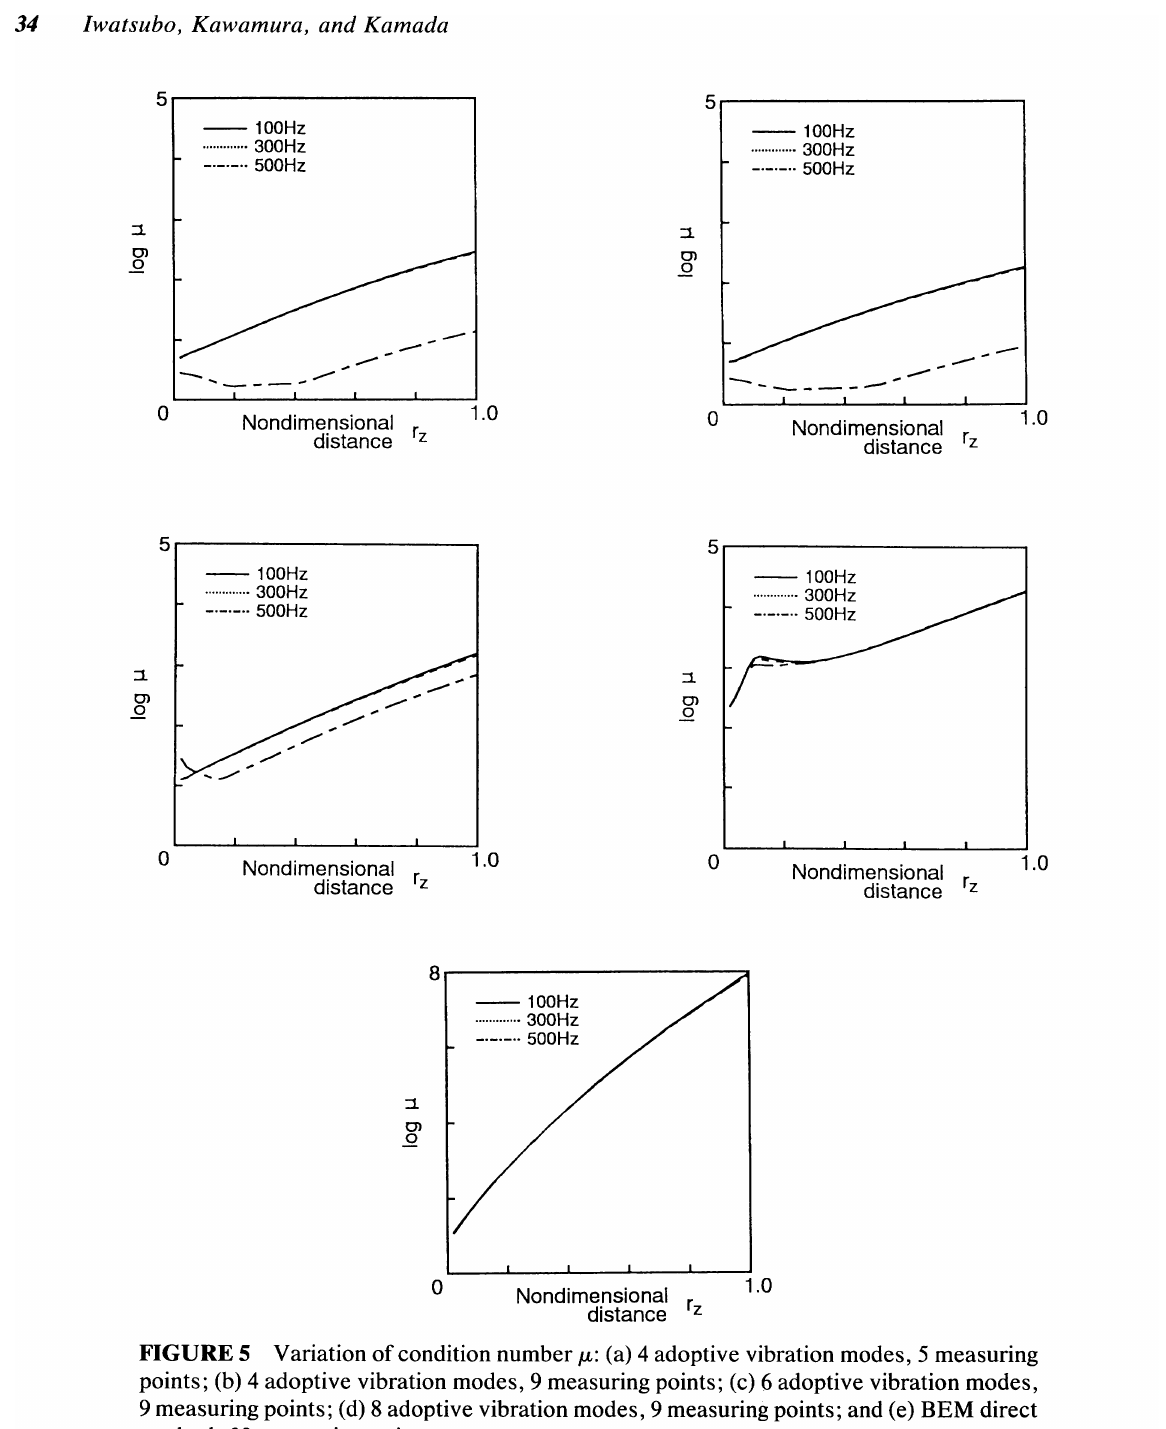
FIGURE 5 Variation of condition number j.t: (a) 4 adoptive vibration modes, 5 measuring points; (b) 4 adoptive vibration modes, 9 measuring points; (c) 6 adoptive vibration modes, 9 measuring points; (d) 8 adoptive vibration modes, 9 measuring points; and (e) BEM direct method, 32 measuring